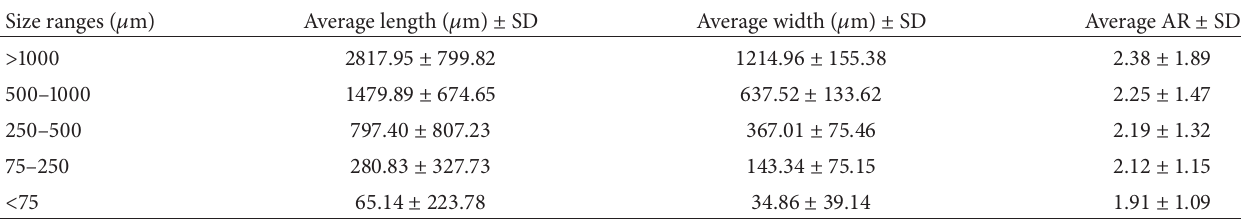
Table 1: Average dimensional parameters of wheat straw powders in different size